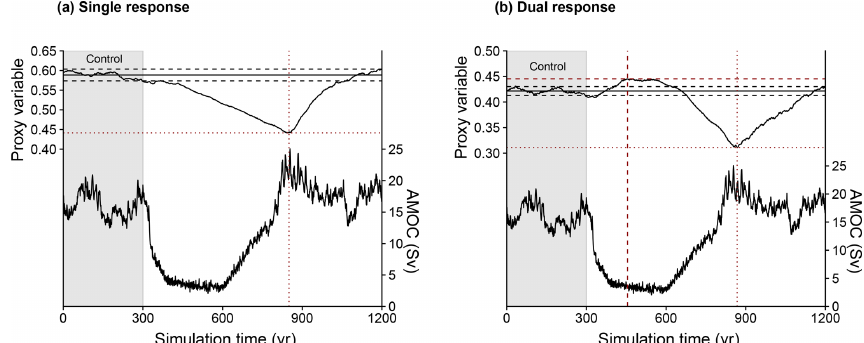
Figure 2. Theoretical definition of the proxy response studied (dotted red horizontal line) and the time of response (dotted vertical red line) in the case of (a) a single response or (b) a dual response to the circulation change induced by the freshwater addition. In the case of dual response, we examine the early (i.e. the first) and the late (i.e. the second) proxy response and time of response. The anomaly is defined as the difference between the proxy value at the defined time of response and the average proxy value (horizontal black line) during the control period of 300 years (highlighted in grey). The horizontal dashed black lines represent the proxy variance (2 σ ) over the control period (highlighted in grey). The proxy variable used is purposely not specified since the interest here is to provide an illustration of the definition used in the present study with the different modelled proxy